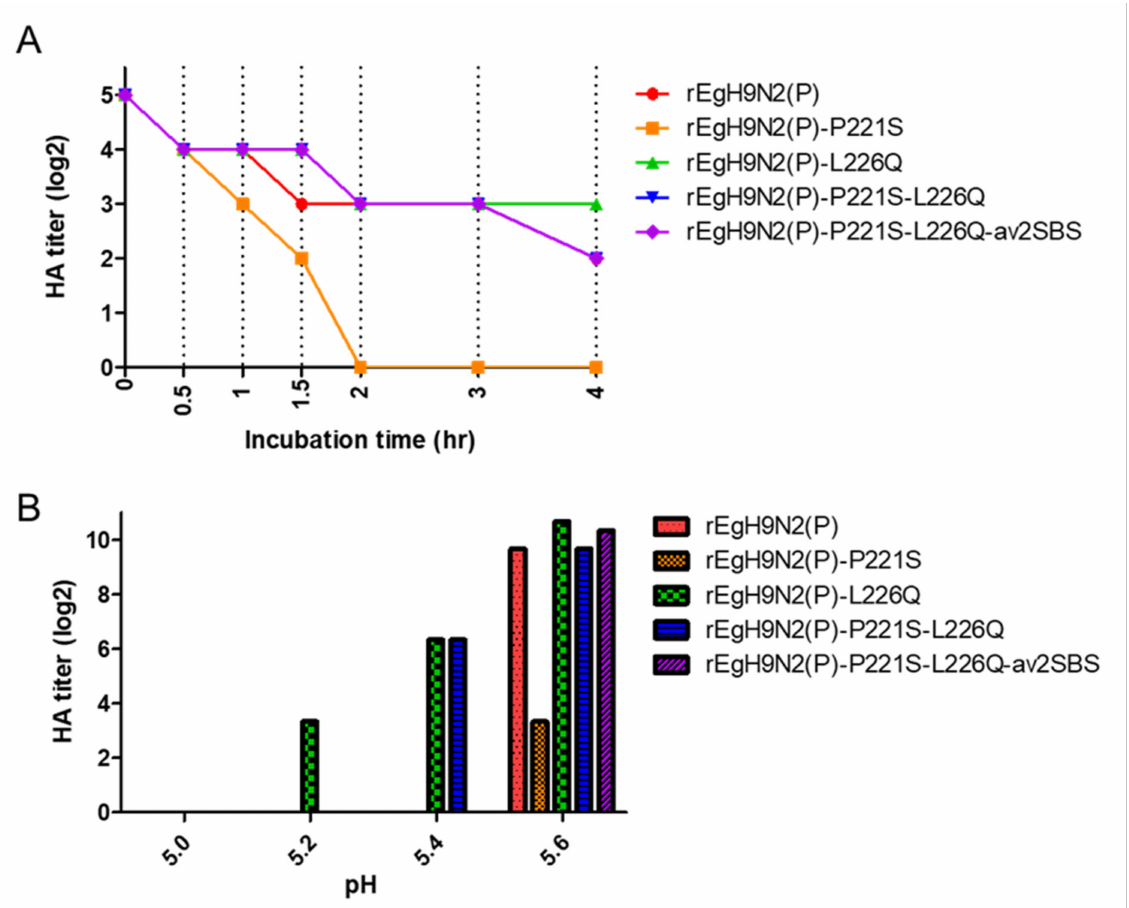
Figure 6. Relatively high heat stability and low pH susceptibility of recombinant Egyptian H9N2 strains. ( A ) Each recombinant virus was diluted to 32 (2 5 ) HAU and incubated at 56 ◦ C for 0.5, 1, 1.5, 2, 3, and 4 h. After heat treatment, the HA titer of each aliquot was measured and recorded. ( B ) A total of 10 7 EID 50 of viruses was mixed with pH buffer (5.0–5.6) at a 1:100 ratio and incubated at 37 ◦ C for 1 h. Mixtures were diluted with PBS (pH 7.4) at a 1:100 ratio and inoculated into three 10 day old ECEs. The HA titers of viral replicates in harvested allantoic fluid after 72 h were compared. 3.9. The Six Internal Genes of PR8 Facilitate While the 01310 PB2 Gene Completely Attenuates Replications of Recombinant Egyptian H9N2 Strains in Mammalian Cells The potential mammalian pathogenicity of AIVs can be predicted by replication efficiency in MDCK and A549 cell lines. In particular, A549 is an in vitro model that is in good correlation with the BALB/c mouse model [43]. The growth kinetics of recombinant Egyptian H9N2 strains that showed high virus titers in ECEs were investigated in MDCK and A549 cells (Figure 8). rEgH9N2(P)-310PB2 and rEgH9N2(P)-310PB2-P221S-L226Q- av2SBS possessing 01310 PB2 did not replicate in MDCK and A549 cells at any time point, as expected. However, all Egyptian H9N2 strains with the PR8 PB2 gene replicated efficiently enough to reach significantly higher titers than rPR8 at 24 h post inoculation (hpi). Therefore, reverse mutations to increase avian receptor affinities of HA and NA did not reduce viral replication efficiency in MDCK and A549